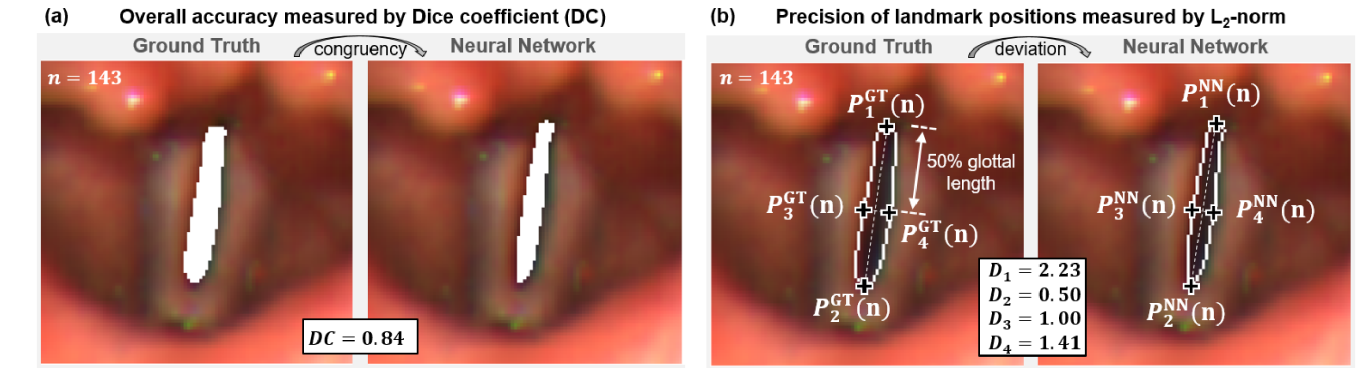
Fig 3. Quantifying the segmentation accuracy by comparing ground truth and Neural Network segmentations. (a) Overall segmentation accuracy of the glottis was measured using the Dice Coefficient. (b) Spatial segmentation precision was quantified by computing the deviation D i ( n ) at the four landmark positions P i ( n ) using the L 2